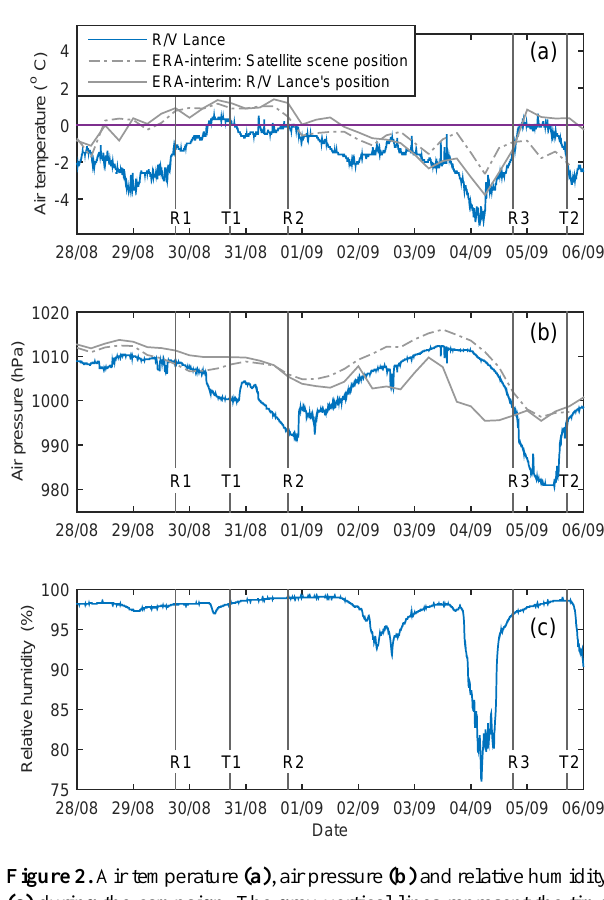
Figure 2. Air temperature (a) , air pressure (b) and relative humidity (c) during the campaign. The grey vertical lines represent the time of the acquisition of the satellite scenes.